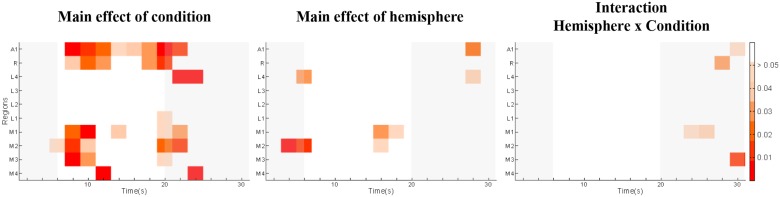
Time frame by time frame 2-way ANOVA condition (REP, CTRL) x hemisphere (RH, LH) for each of the 10 early stage areas (A1, R, L1, L2, L3, L4, M1, M2, M3, M4).Gray shading highlights the rise and decay periods, red hues denote significant effects at a given time point and area. During the plateau phase a significant main effect of condition was present in A1, R, M1, M2, M3 and M4 as well as a significant main effect of hemisphere at isolated time points in M1 and M2.